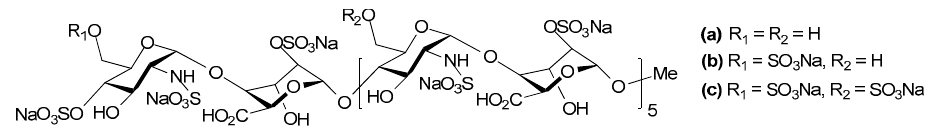
Figure 12. Site-specifically 6- O -sulfated dodecasaccharides: ( a ) completely non-6- O -sulfated ( b ) site-selectively mono-6- O -sulfated ( c ) fully 6- O -sulfated.